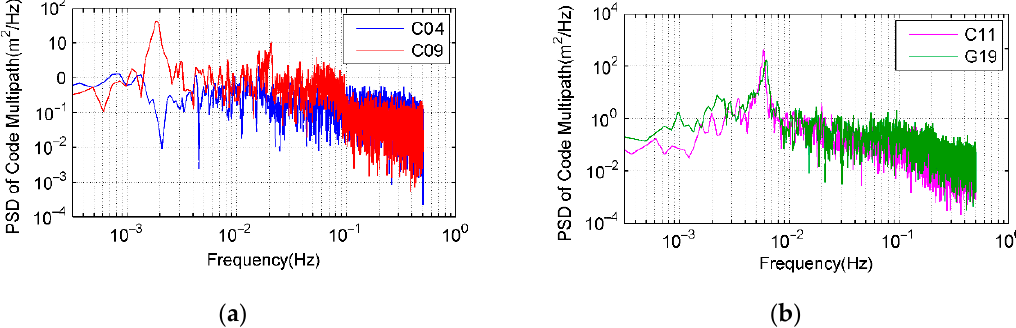
Figure 4. PSD of code multipath (from 9:00 a.m. to 10:30 a.m. local time in DOY 310). ( a ) C04 and C09; ( b ) C11 and G19.